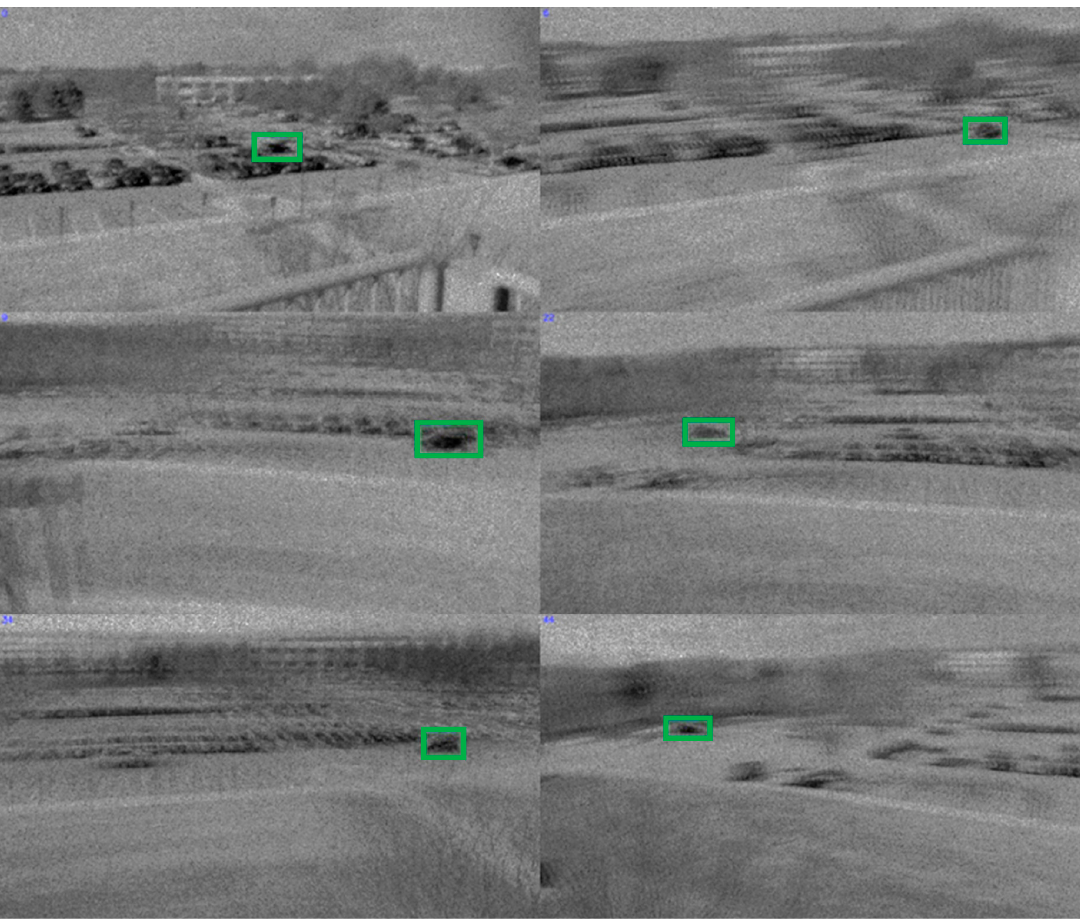
Figure 11. Fire escape video IMG428 with 50 percent missing tiled image results. Bounding box detections outlined in green.